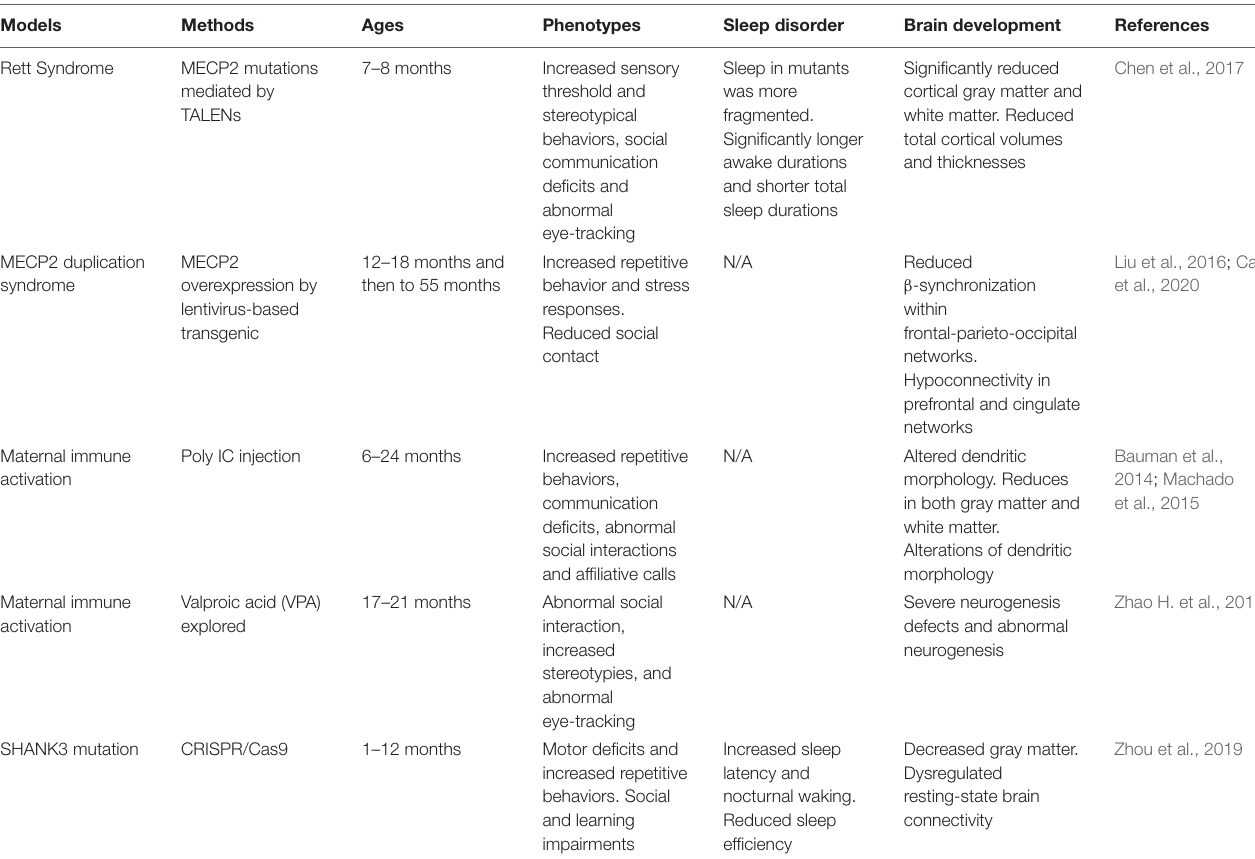
TABLE 2 | Autism-relevant phenotypes in selected primate